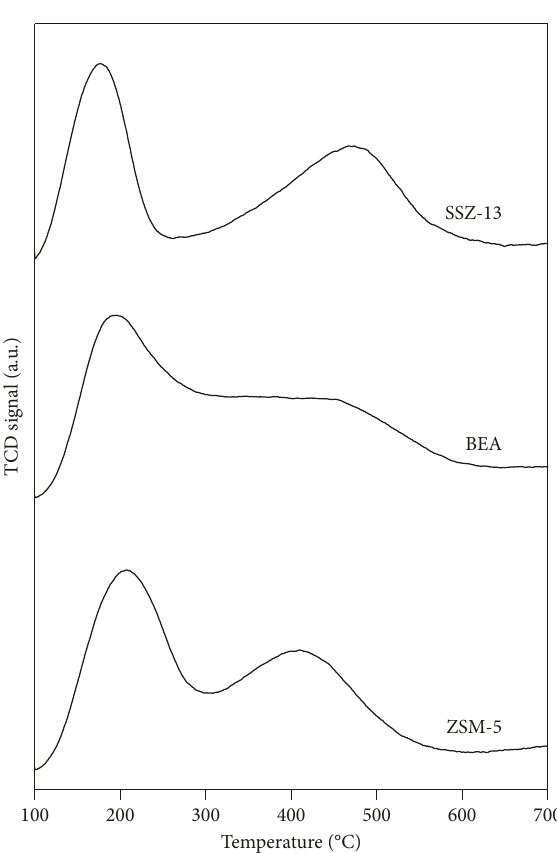
Figure 1: NH 3 -TPD profiles of zeolite